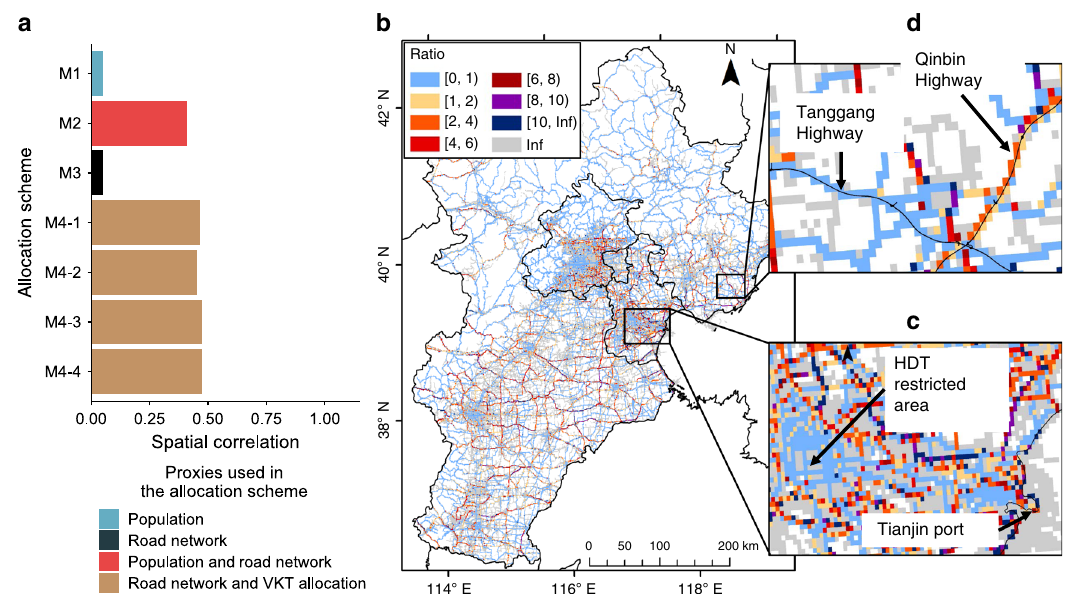
Fig. 3 Comparison of high-resolution (0.01 ˚ × 0.01 ˚ ) HDT emissions calculated with the TrackATruck method and with various proxy-based allocation schemes. a Pearson ’ s correlations among NO x emissions. M1 represents that the total emissions are allocated by population density. M2 represents that the total emissions are allocated by the road network. M3 represents that the total emissions are allocated by population density as well as the road network. M4-1 to M4-4 represent that total emissions are allocated using the road network with different VKT allocations. The total HDT emissions are set as same in all schemes. b The ratio of HDT emissions for each 0.01° grid between this study and the M4-1 method. c Tianjin Port area. d Two Hebei highways (Tanggang and Qinbin Highways) in b. *Source data are provided as a Source Data fi le.